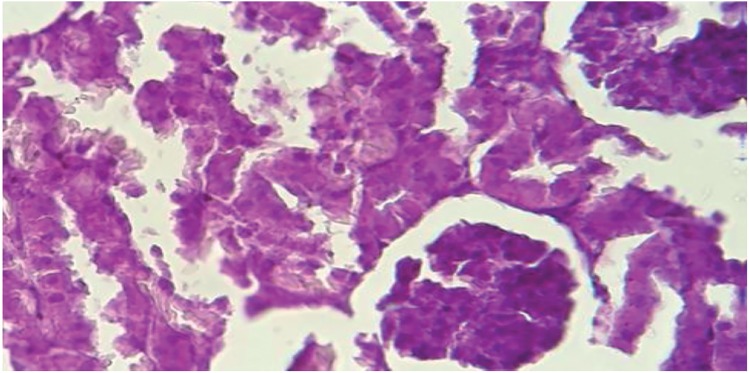
Accumulation of calcium oxalate crystals in kidney tubules in the cotreatment group (plant extracts with probiotic).